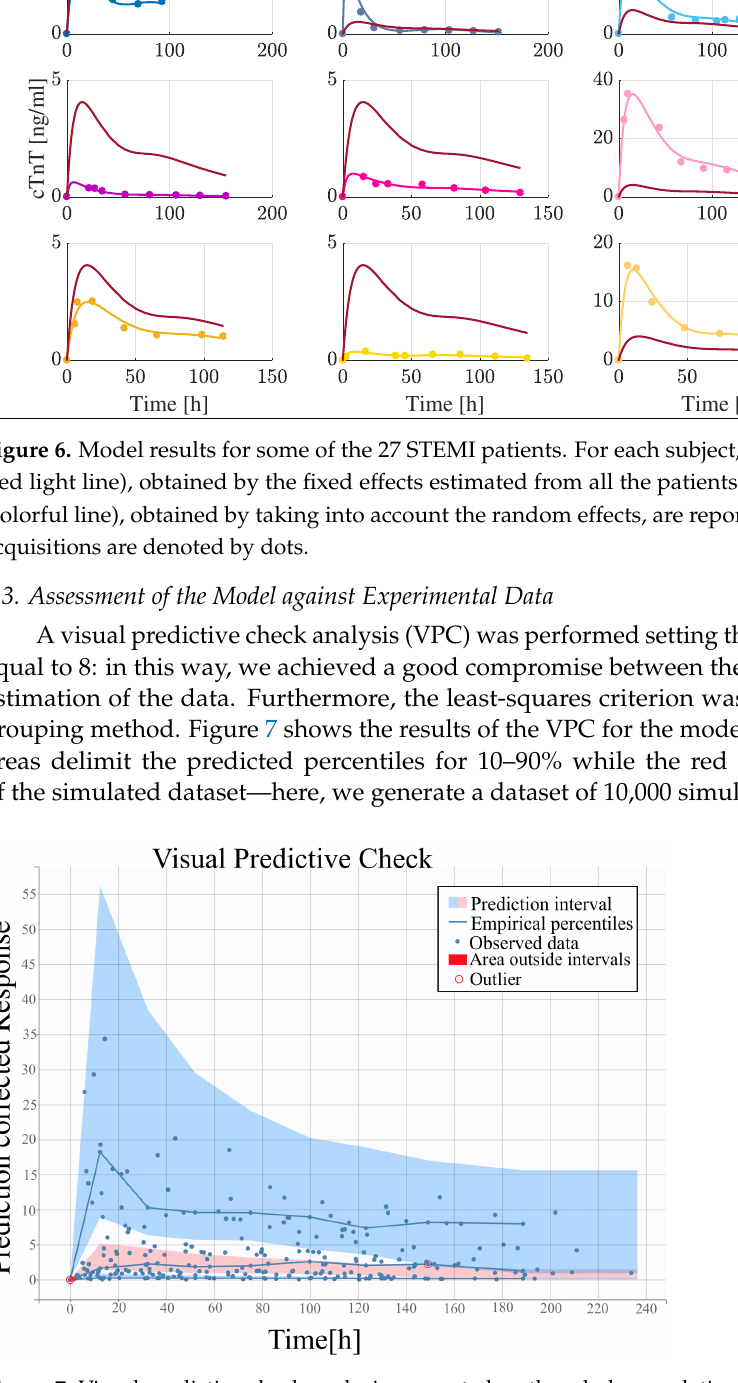
Figure 7. Visual predictive check analysis computed on the whole population, and obtained by simu- lating, through the Monte-Carlo method; 10,000 time